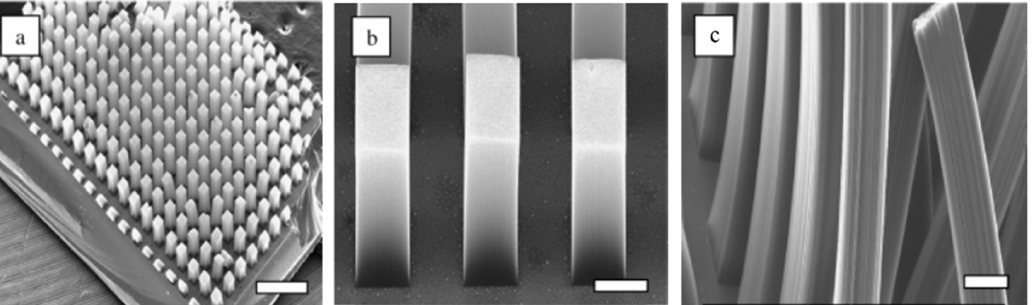
Figure 1. The approaches for aligning CNTs and the schematics of unordered and ordered CNTs.